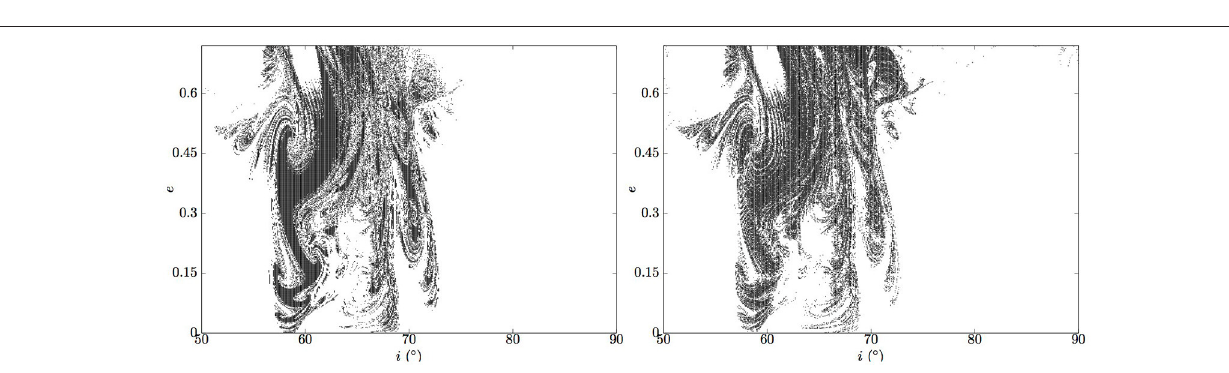
FIGURE 6 | Extraction of the ICs satisfying D( x , τ run )